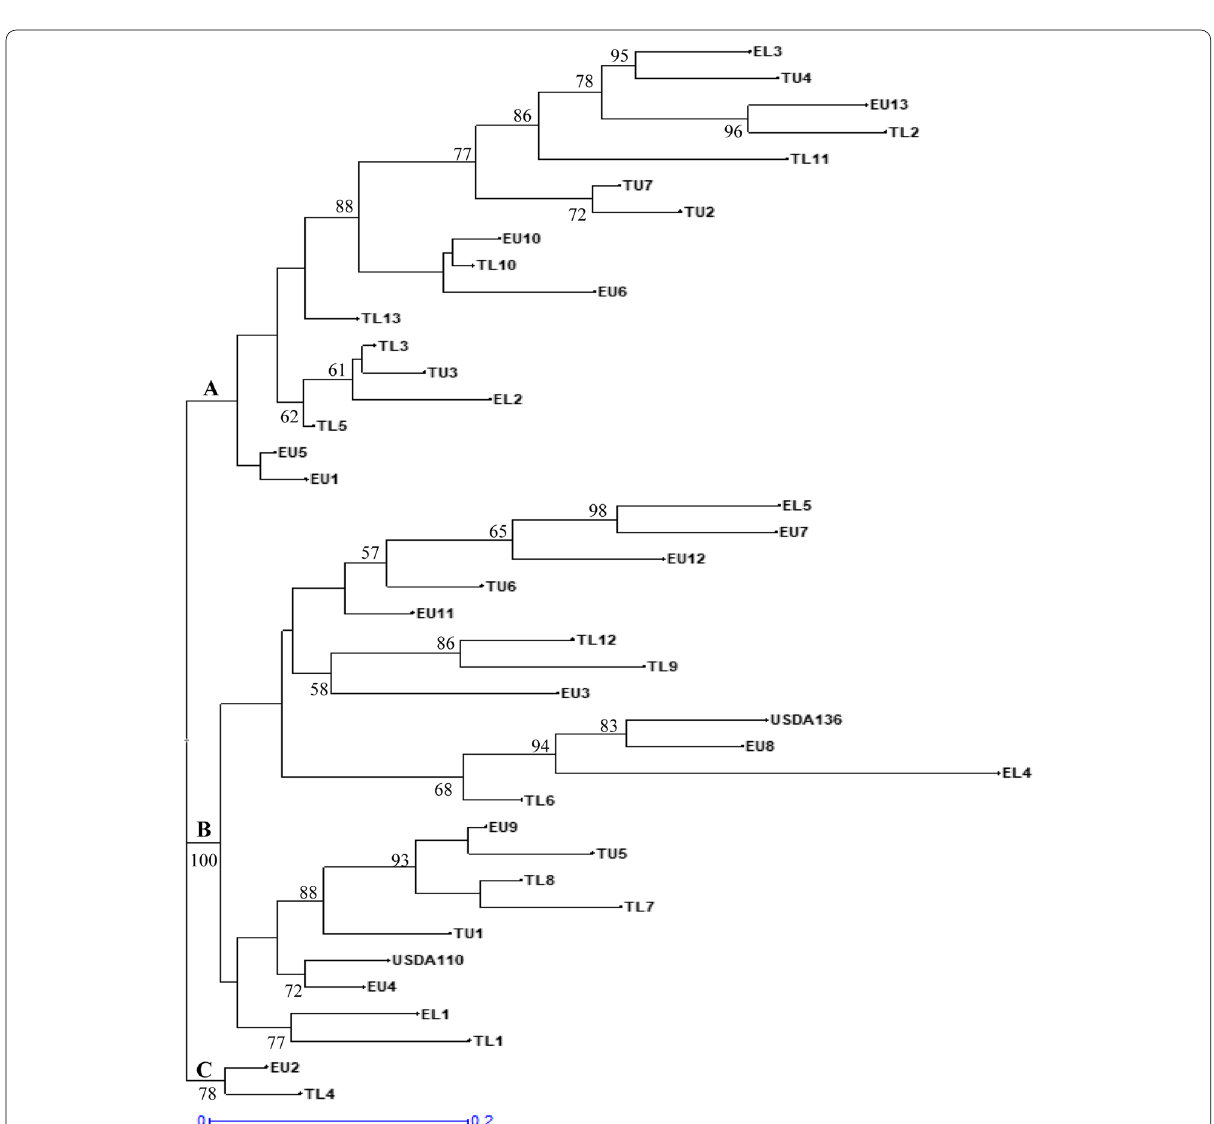
Fig. 6 Phylogenetic relationship of 38 indigenous bradyrhizobia isolates and two reference strains (USDA110 and USDA136) based on combined Hae III, Msp I, and EcoR I restriction patterns of amplified 16S rRNA gene inferred using maximum likelihood method. Only bootstrap values